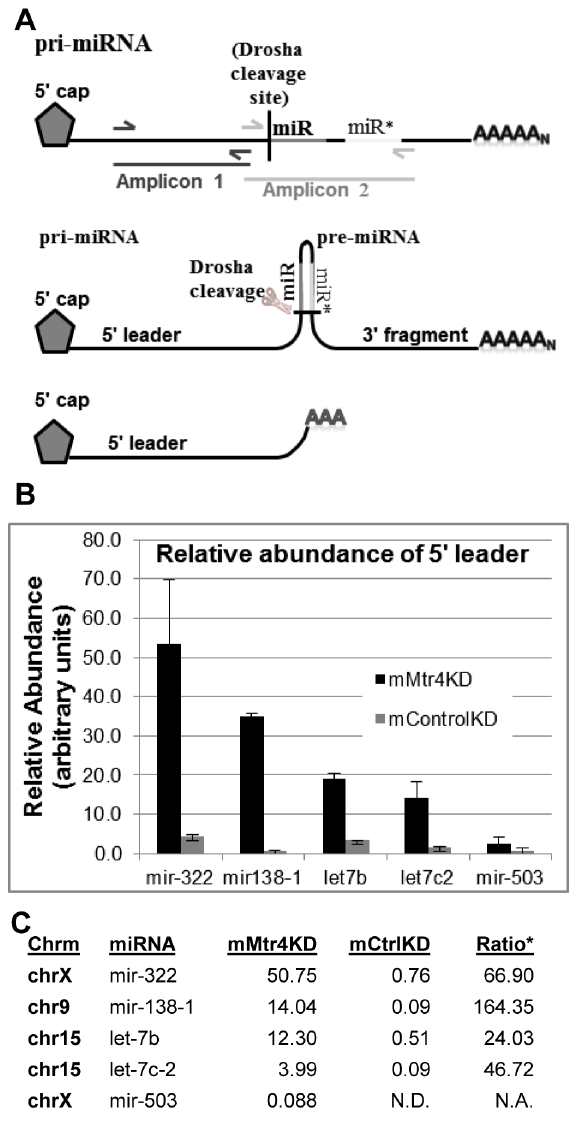
Figure 6. Adenylated 5 9 leader sequences from pri-miRNAs accumulate in the mMtr4 KD. A. Schematic depicting relevant aspects of miRNA processing. Primary miRNA transcripts are produced by RNA polII and include both a 5 9 cap and poly(A) tail. The miRNA and complementary mir* contribute to formation of a hairpin, and Drosha cleaves near the base of the hairpin to liberate the pre-miRNA [103]. mMtr4 KD PA-seq identified adenylated 5 9 leader transcripts whose 3 9 end specifically maps to the Drosha cleavage site. qRT-PCR validation of these data compared amplification results for primers within the 5 9 leader (eg. Amplicon 1, depicted on uppermost diagram) to primers that span the Drosha cleavage site (Amplicon 2) as a control for pri- miRNA abundance. B . Relative expression of miRNA 5 9 leader sequences was calculated using the DD Ct method from triplicate reaction realtime PCR data. All reactions were performed in triplicate, further averaged over 3-4 independent qPCR runs for each miRNA 5 9 leader, and shown relative to parallel qPCR reactions detecting Cyclophilin B mRNA. All Y- axis values represent relative arbitrary units. C . Combined PA-seq data for miRNA 5 9 leader sequences reported as reads per million, and ratio of mMtr4 KD over mControl KD.